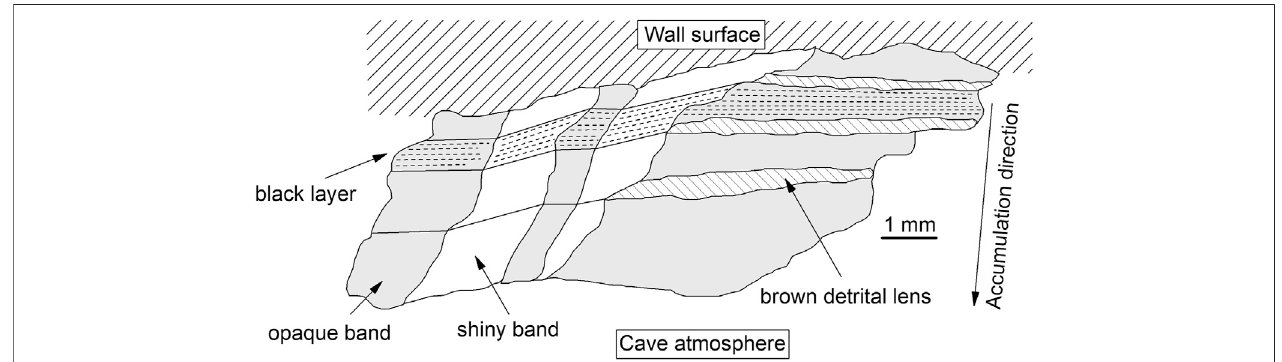
FIGURE3| SketchofthesampleGCshowingthebrowndetritallenses,blacklayers,andthelateralalternationofshiny(whitecolour)andopaque(gray)bands.The dashed lines show the orientation of the layering within the opaque and shiny bands (horizontal and transversal, respectively).